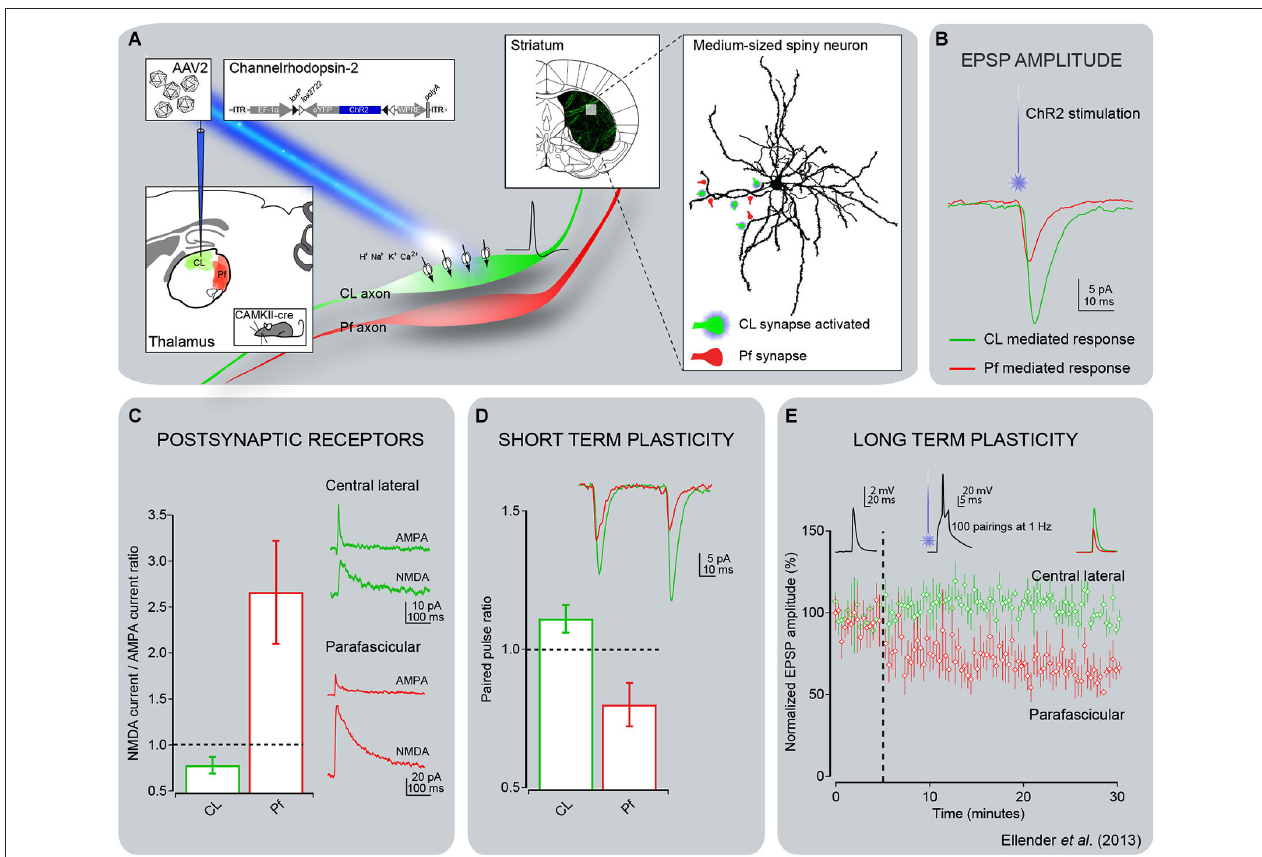
AMPA receptor-mediated currents in response to light activation and the Pf synapses exhibit predominantly NMDA receptor-mediated currents. (D) The short term plastic properties of these synapses were investigated by repetitive activation of the synapses in close succession. This revealed that inputs from CL exhibit short term facilitation, in which the response to the second activation has a larger amplitude than the response to the first activation, whereas inputs from Pf exhibit short term depression. (E) The long term plastic properties of these synapses were investigated using a spike timing-dependent plasticity protocol, consisting of the pairing of optical activation of a pre-synaptic thalamic input with a post-synaptic action potential in a MSN. This protocol induced a clear long term depression of synaptic efficacy at Pf synapses, but no plasticity was observed at CL synapses. The same observation was made using either a pre-post or post-pre pairing, with only the pre-post pairing shown for clarity (see Ellender et al., 2013 for more